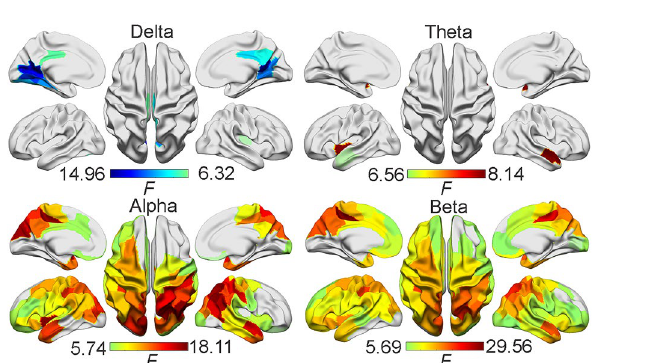
Figure 4. Age-related changes on measures for long-range transitions involving two polarized CAPs: ( A ) Occurrence rate; ( B ) Mean duration time; ( C ) Mean numeric counts of other CAPs visited. The line in each panel denotes the liner regression model, whose p values are listed in the panels (red frames: survived with Bonferroni correction).